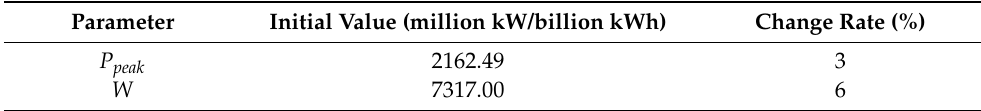
Table A3. Forecasting parameters of power